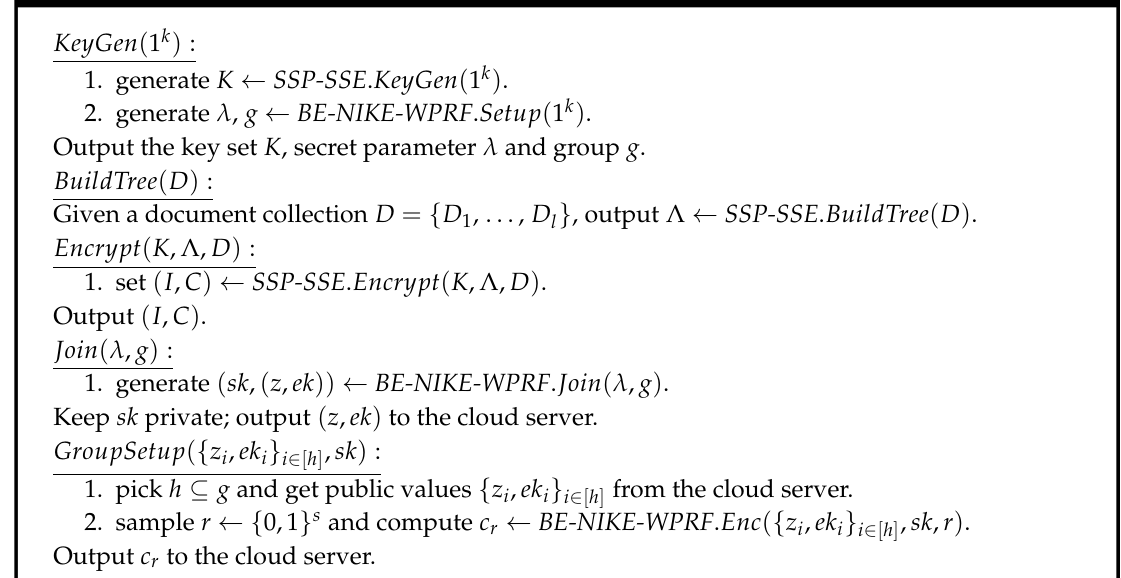
Algorithm 5 : MSSP-SSE